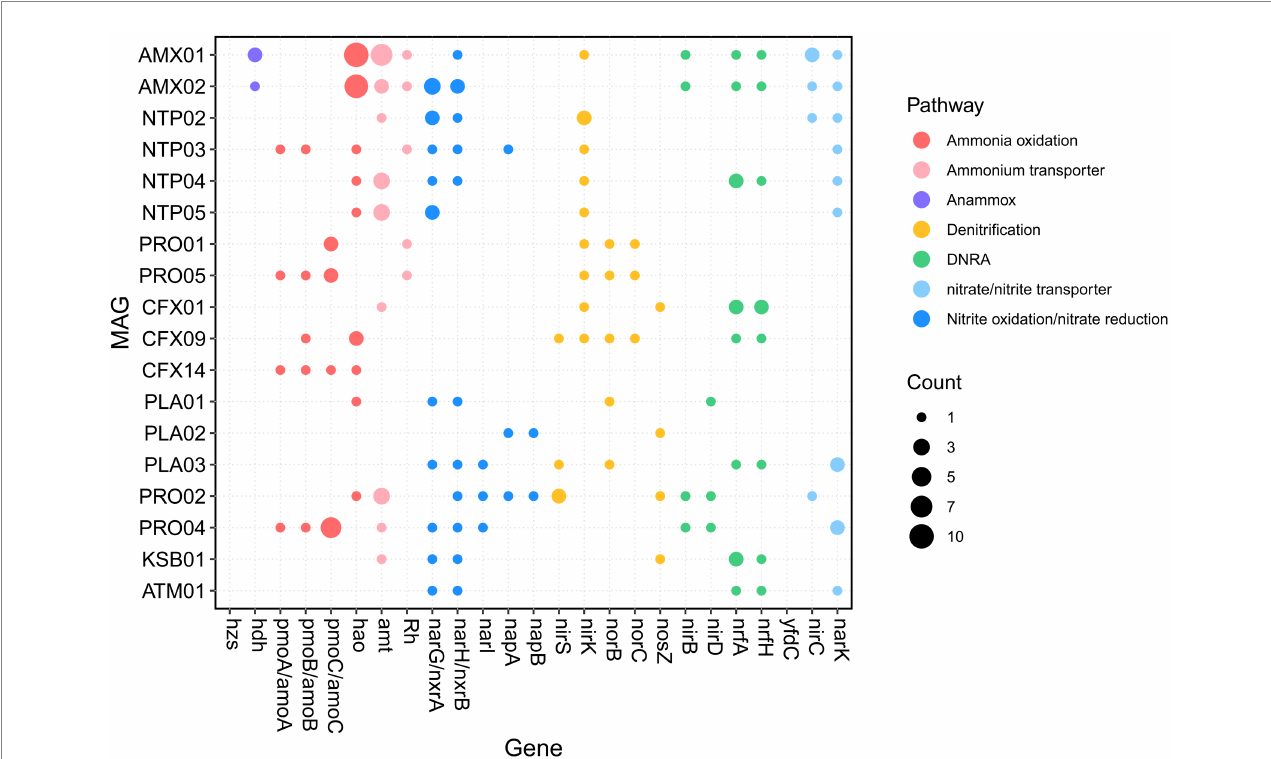
FIGURE 2 Distribution of the nitrogen-converting functional genes retrieved from the 18 core